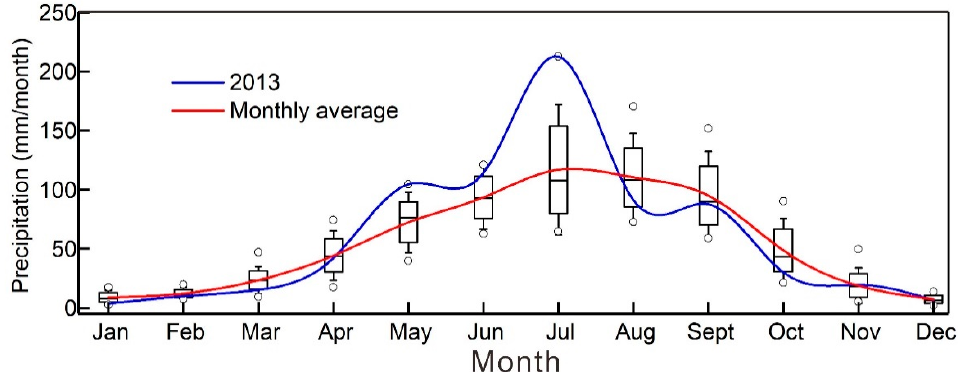
Figure 2. Map showing a comparison of the rainfall in each month in 2013 (blue line) with the average rainfall over the last 20 years from 2000 to 2020 (red line) in the Tianshui area.